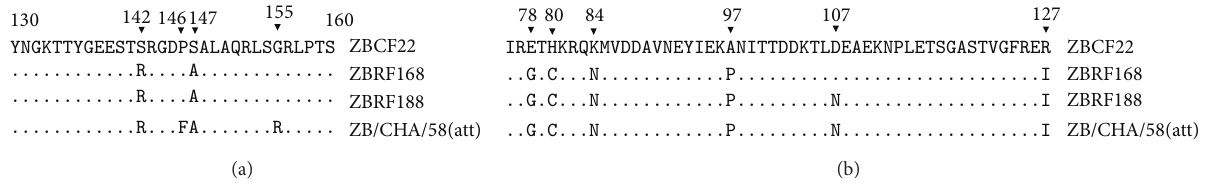
Figure 3: Comparison of amino acid differences between the ZB virulent and attenuated strains: (a) VP1 antigen site B (aa130-160) and (b) 3A (aa76-127).